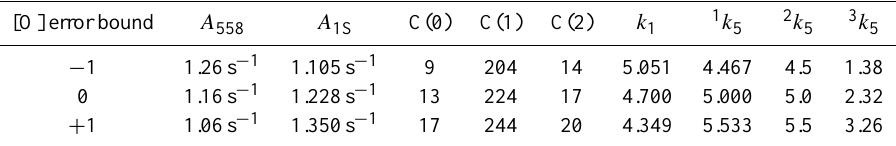
Table 2. Einstein coefficients ( A 558 , A 1S ), excitation parameters (C(0), C(1), C(2)) and factors ( k 1 , 1 k 5 , 2 k 5 , 3 k 5 ) for rate coefficients ( κ 1 , 1 κ 5 , 2 κ 5 , 3 κ 5 ). The values are presented in the table according to their position in the Eq. (15) that gives the retrieved atomic oxygen concentration (see Table 1, Sect. 5 and Appendix for